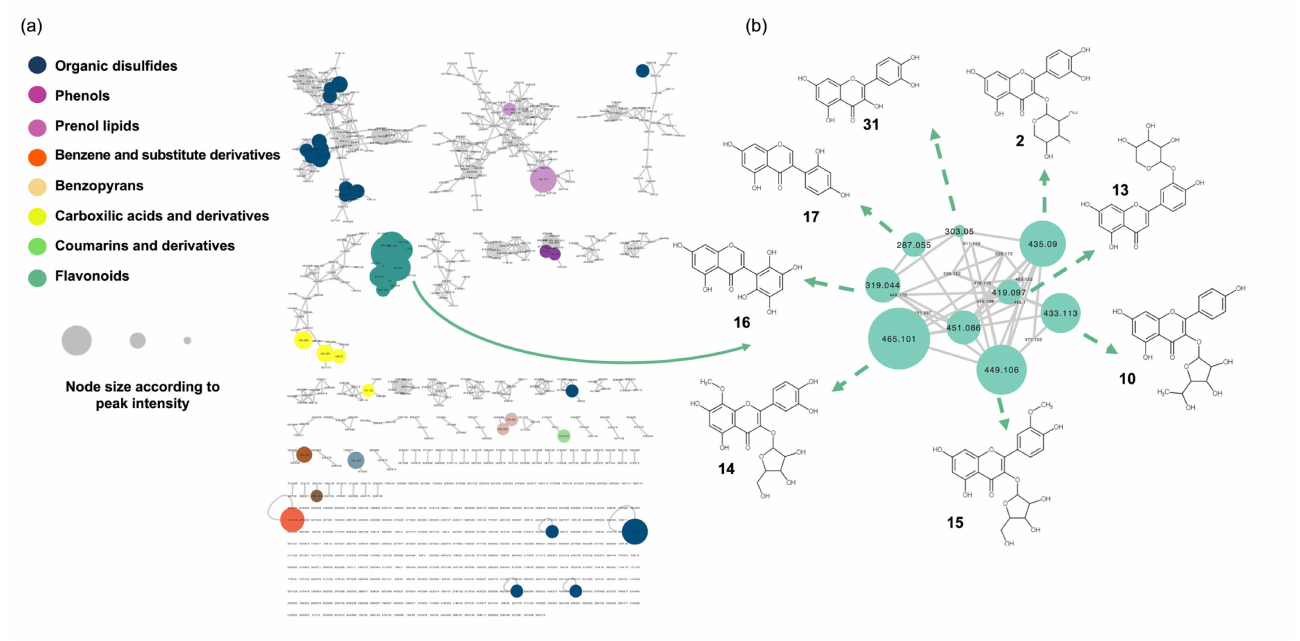
Figure 1. Molecular network analysis of the hydroalcoholic leaf extract of Bauhinia ungulata. ( a ) Color of the node indicates the chemical class of the compound. The node size is set according to the peak area of the mass signal. ( b ) Selected cluster, containing flavonoid derivatives. The chemical structure of the dereplicated compounds is given. Table 1. Identification of compounds in the hydroalcoholic leaf extract of Bauhinia ungulata by UHPLC-HRMS 2 analysis in the positive mode. The InChIKey (International Chemical Identifier) for the annotated metabolites is